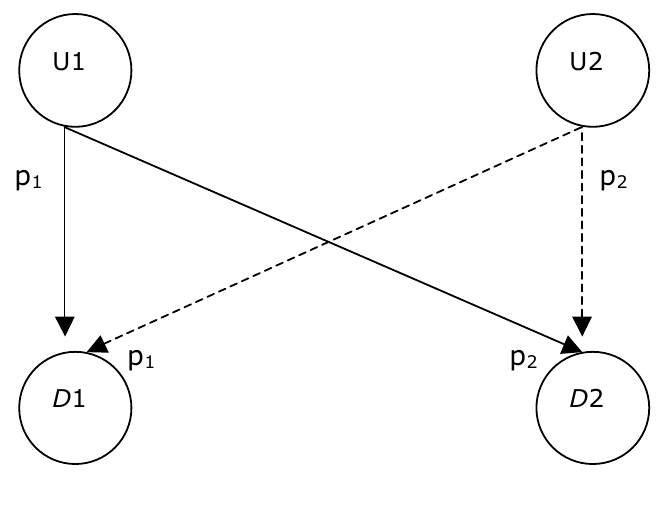
Figure 2. “Competition under non incentive contract